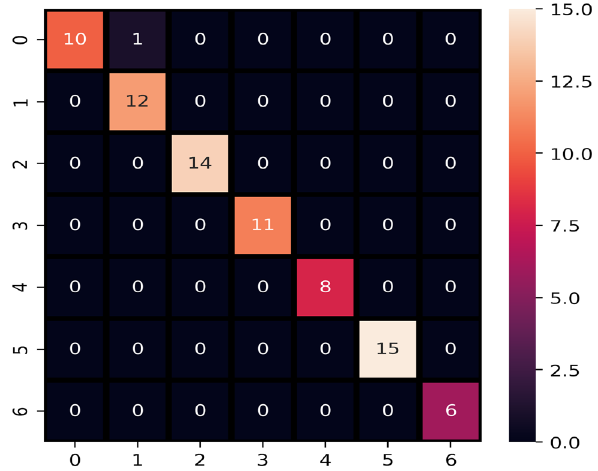
Figure 4. Confusion matrix of best performer LVTrees after applying ADASYN technique.